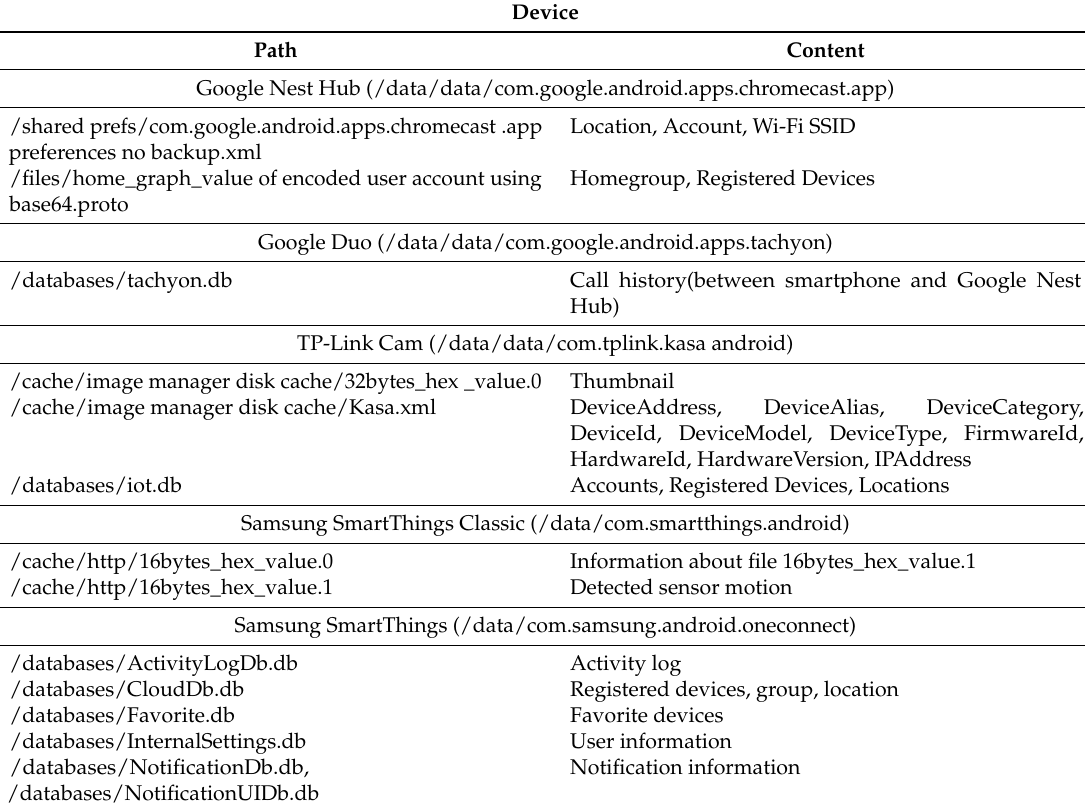
Table 5. Path and data of smart home